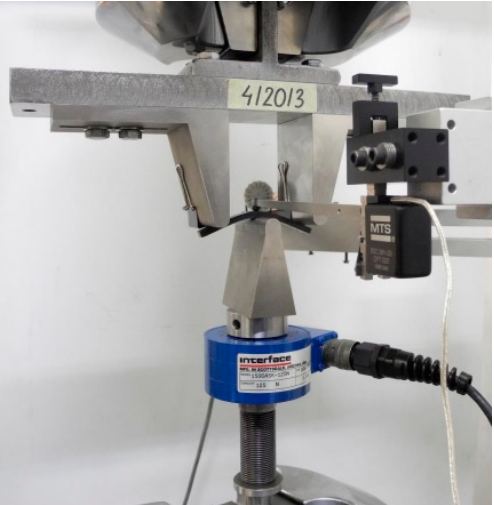
Figure 9. View of the sample fixed in the strength machine after stopping the test.